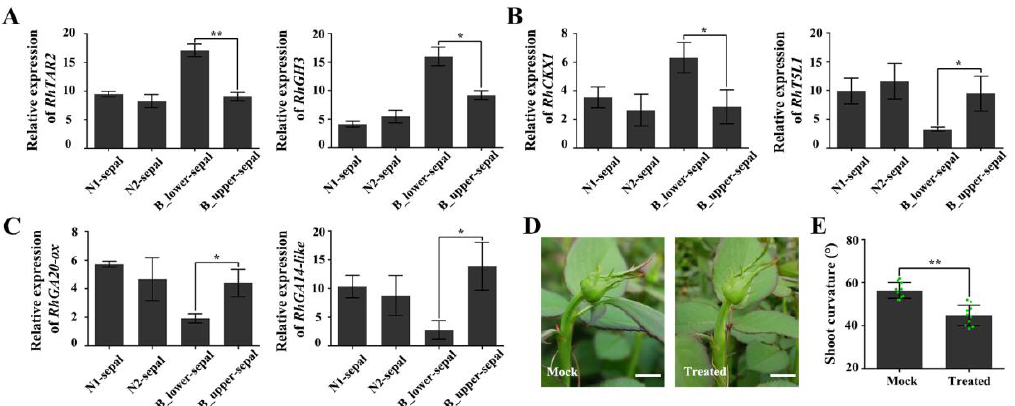
Figure 7. The expression of auxin-, cytokinin-, and gibberellin-related genes in deformed sepals determined by qRT-PCR. ( A ) Auxin-response genes RhTAR2 and RhGH3 . ( B ) Cytokinin-response genes RhCKX1 and RhT5L1 . ( C ) Gibberellin-related genes RhGA20-ox and RhGA14-like . ( D ) BP phenotype 3 days after removal of deformed sepals. Mock, plants with deformed sepals. Scale bars = 10 mm. ( E ) Statistics for the bending angle of peduncle 3 days after removal of deformed sepals. Error bars represent SD. Three biological replicates were performed for A, B, and C, and ten biological replicates for E. Asterisks denote statistically significant differences by using Student’s t -test (* p < 0.05, ** p < 0.01).